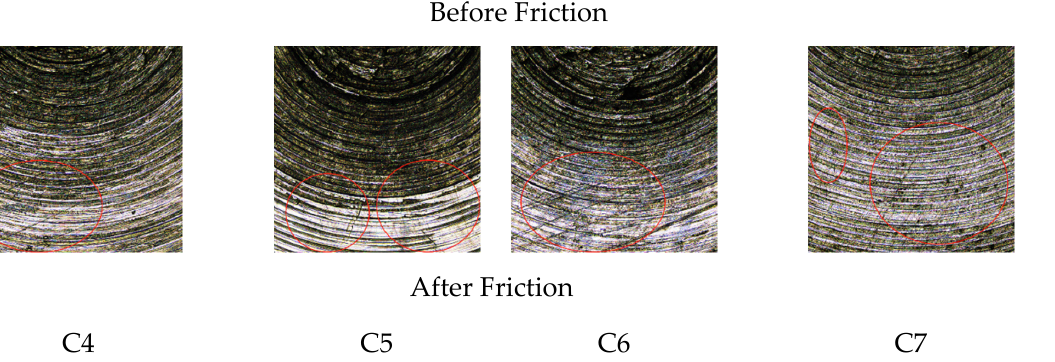
Figure 8. Metal surface morphology. C1 ‐ C7 are the surface morphologies of 7 groups of metals before and after friction.